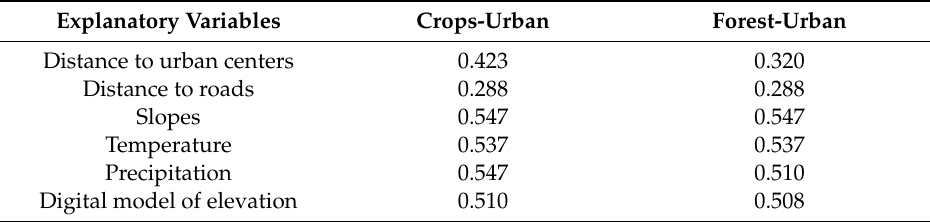
Table 5. Evaluation of the explanatory variables with the Cramer V test.